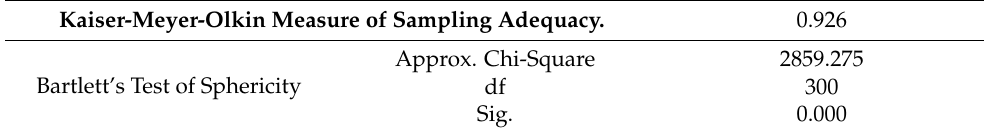
Table 3. KMO and Bartlett’s test (independent variables).